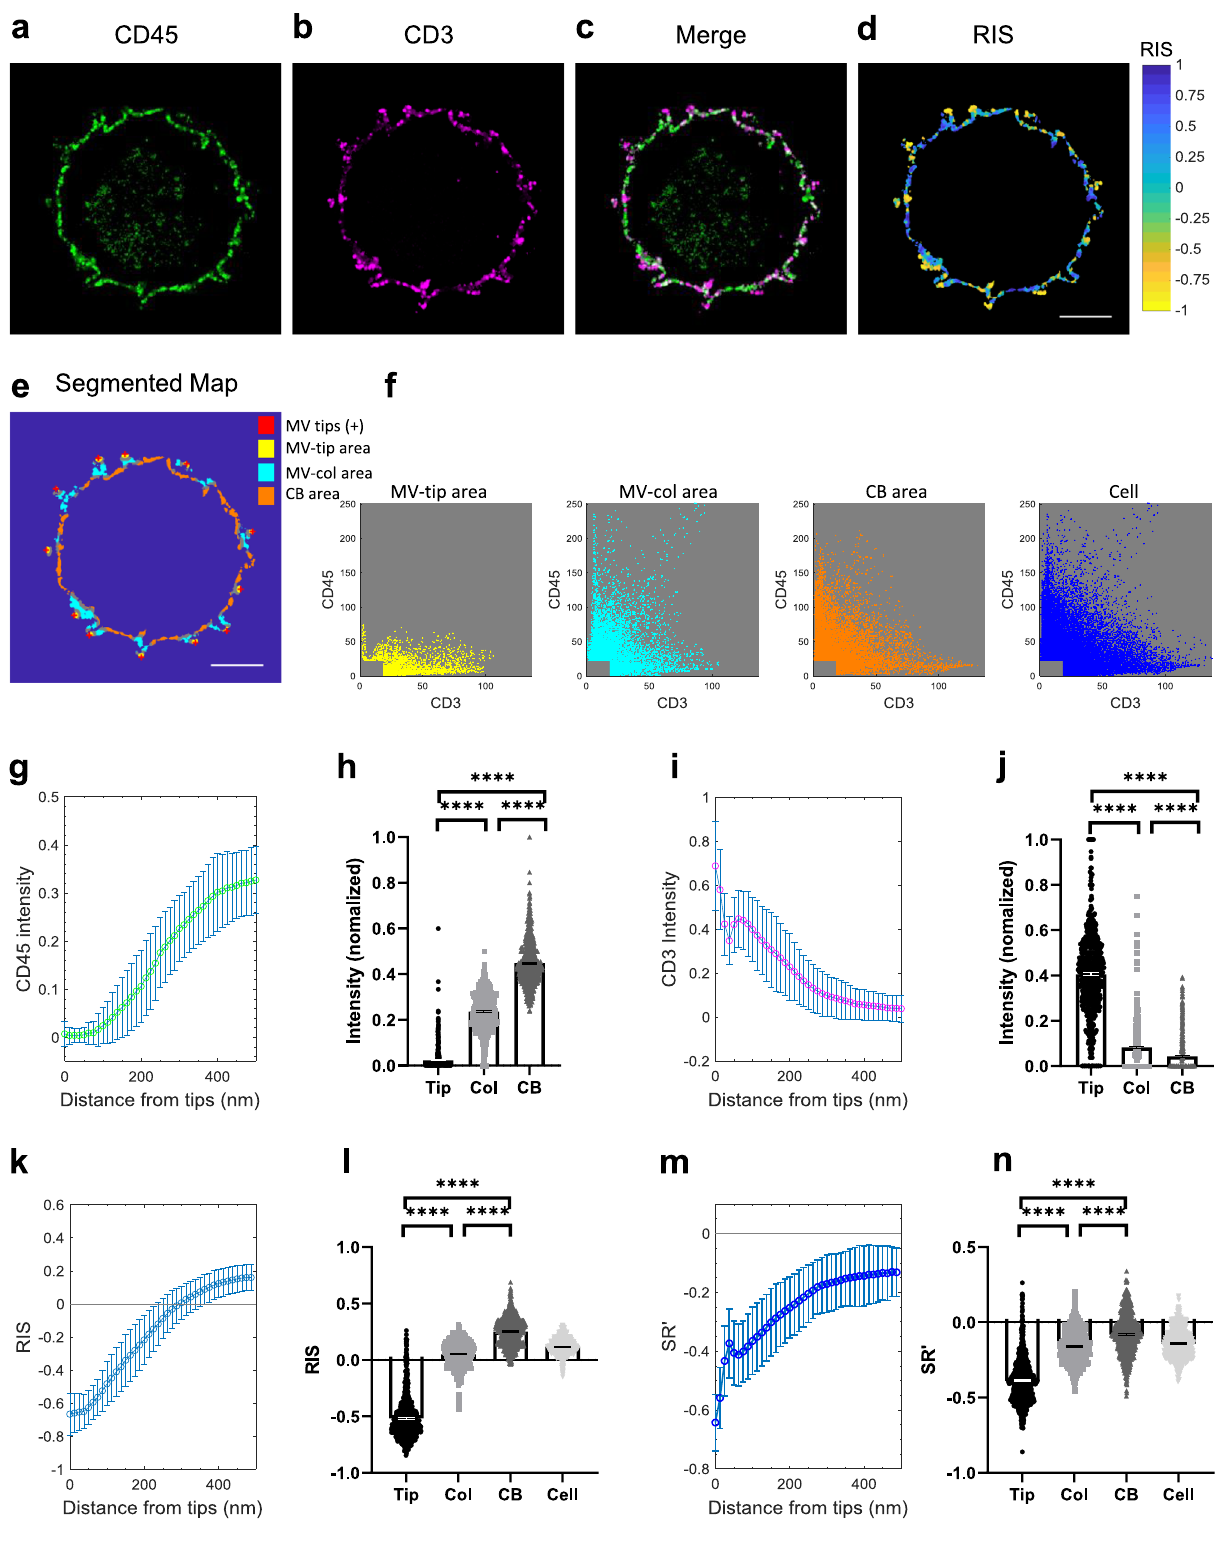
(Supplementary Table 2). For instance, as shown in Fig. 5a, the predicted TM domain lengths of both CD45 and CD3 δ are 21